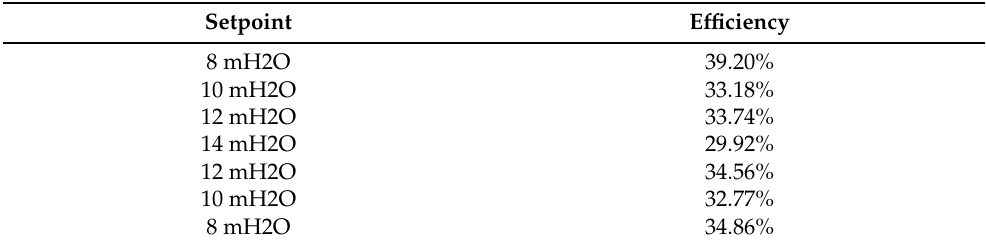
Table 8. Energy efficiency of the system operating with two pumps in parallel for different setpoints. Setpoint